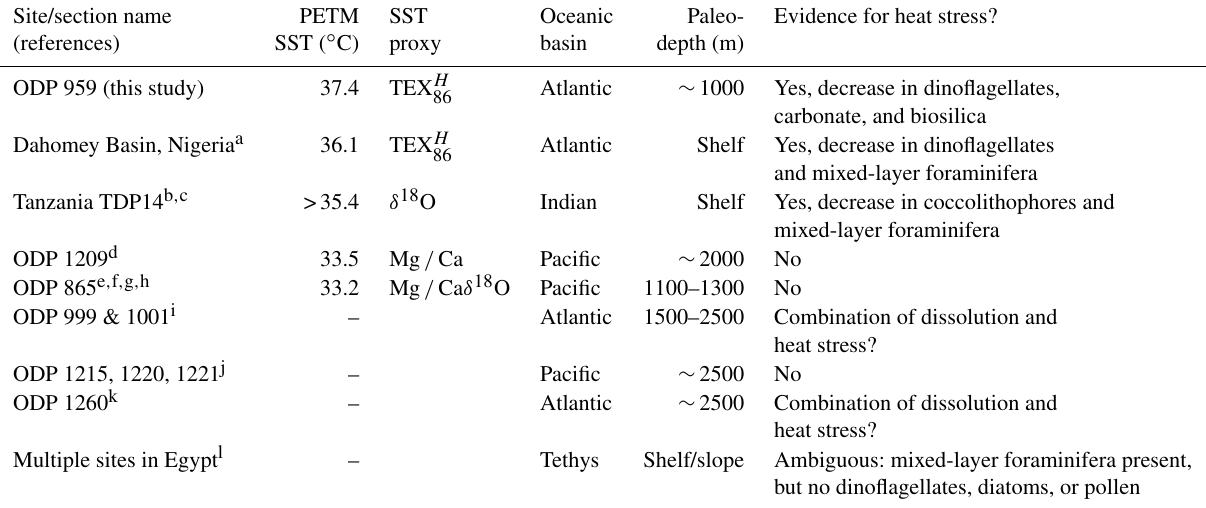
Figure 2. The PETM as recorded by dinoflagellate cyst assemblages at Site 959. (a) δ 13 C TOC in per mill. (b) Concentration of dinocysts per gram of dry sediment. (c) Dinocyst groups in percentage of total dinocysts. The gray band marks the porcellanite. Symbols in white indicate counts <100. Table 1. Compilation of tropical PETM sites and sites that may show evidence for heat stress. Abbreviations are as follows: sea surface temperature (SST), Ocean Drilling Program (ODP), Tanzania drilling program